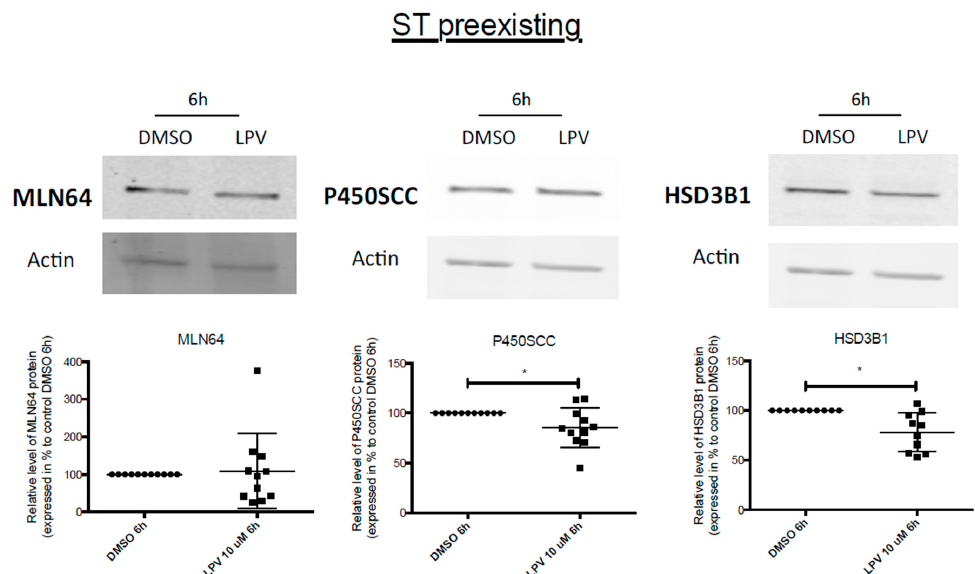
Figure 10. Decrease in enzymes protein expression in ST cells under brief LPV exposition. Cytotrophoblast cells isolated from human term placentas were cultured for 72 h before incubation with LPV 10 µM or DMSO for 6 h. MLN64, P450SCC and HSD3B1 protein expression was evaluated by immunoblotting with anti-MLN64, anti-P450SCC and anti-HSD3B1 antibodies. Actin protein expression determined with anti-actin antibody was used as loading control. Results are expressed as the mean +/ − SD of n = 8 independent experiments. * p < 0.05 vs. DMSO, two-tailed paired no parametric student t -test.